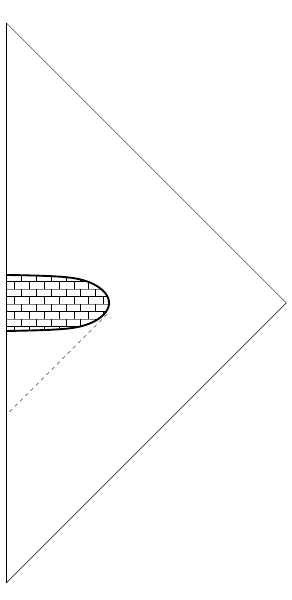
Figure 3. A bouncing interior of a Planck star is ruled out by signature change because the high-density region (indicated as a brick wall) is Euclidean and does not allow deterministic evolution. Boundary values around the Euclidean region, required for a well-posed problem of Tricomi-type, imply indeterministic behavior as shown in Figure 4.